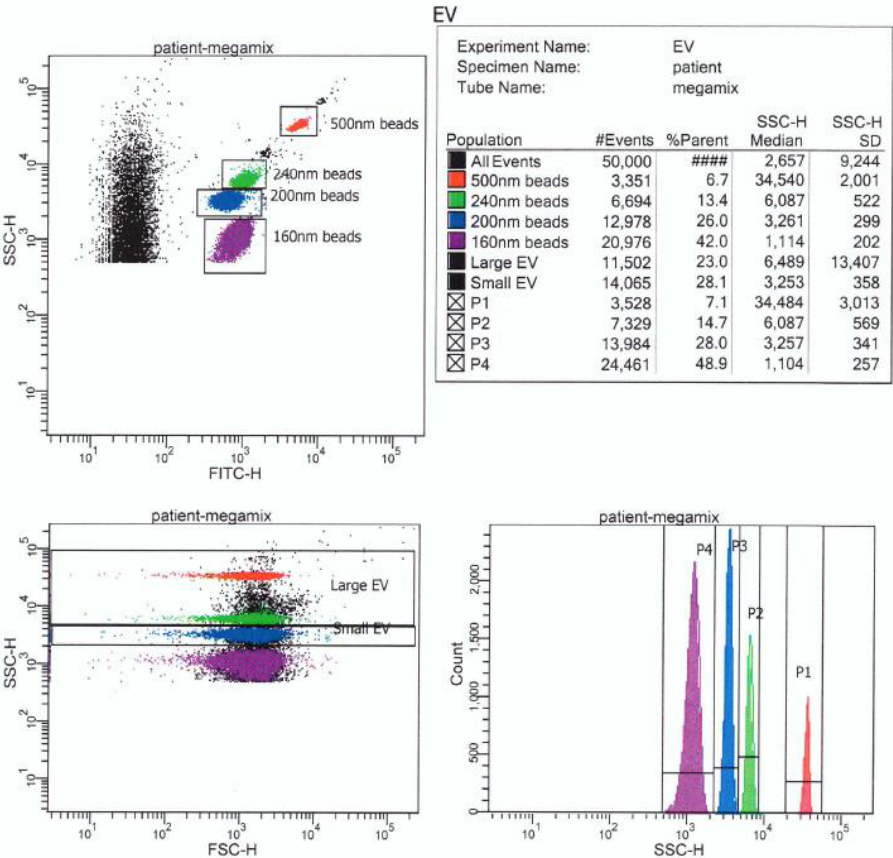
Figure 1. Example of dot plots and histogram of megamix-Plus SSC polystyrene beads using DIVa 8.0.1 software and FACSCantoII flow cytometer (Becton, Dickinson and Company) (own results, unpublished).